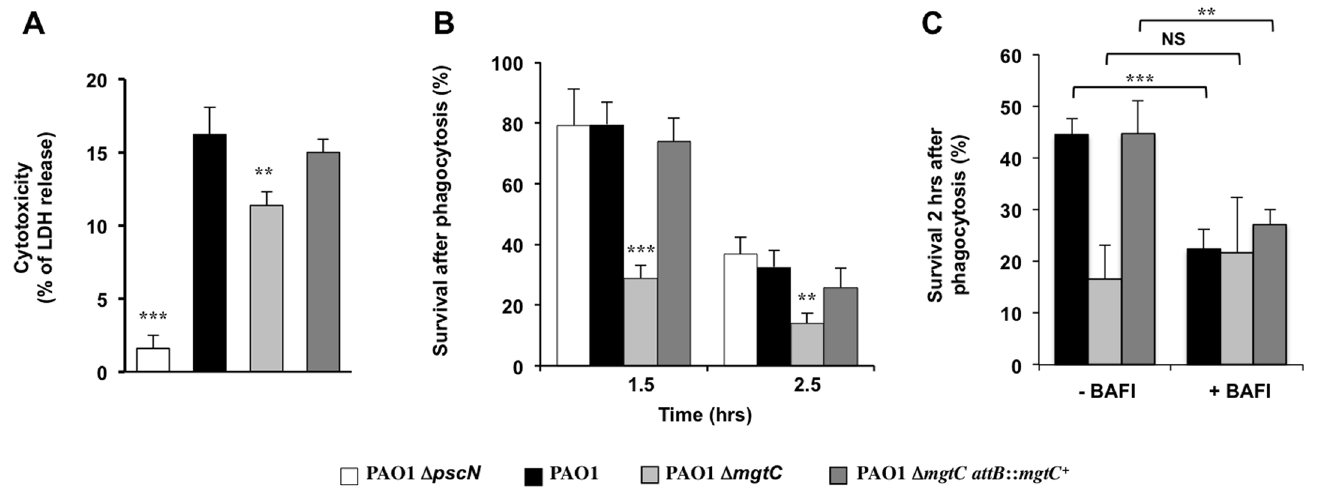
Fig 3. Behaviour of mgtC mutant towards J774 macrophages. (A) Strain cytotoxicity was evaluated using a LDH assay. A T3SS mutant ( Δ pscN ) is included as negative control. Error bars correspond to standard deviations from three independent experiments. (B) Survival of bacteria upon phagocytosis. Results are expressed as percentage of surviving bacteria at the indicated time comparatively to the number of bacteria internalized after 30 min of phagocytosis. Error bars correspond to standard errors (SE) from five independent experiments. (C) Effect of inhibition of vacuolar proton ATPase on bacterial survival. The survival of bacteria was measured from macrophages treated or not with bafilomycin A1. Error bars correspond to standard errors (SE) from three independent experiments. In all panels the asterisks indicate P values (Student ’ s t test, ** P < 0.01, *** P < 0.001).